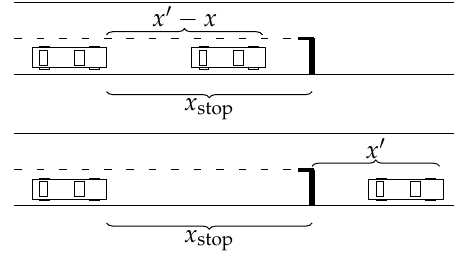
Figure 1. Distance between cars in different